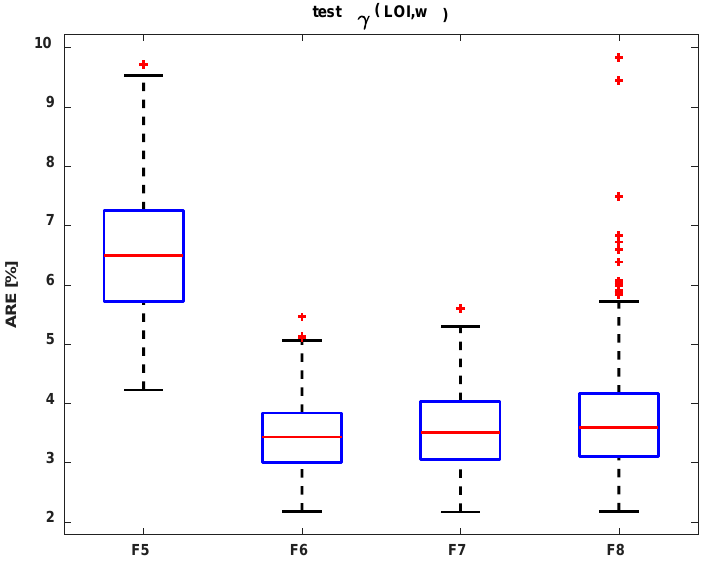
Figure 12. Comparison of the MRE tested models (F5–F8).